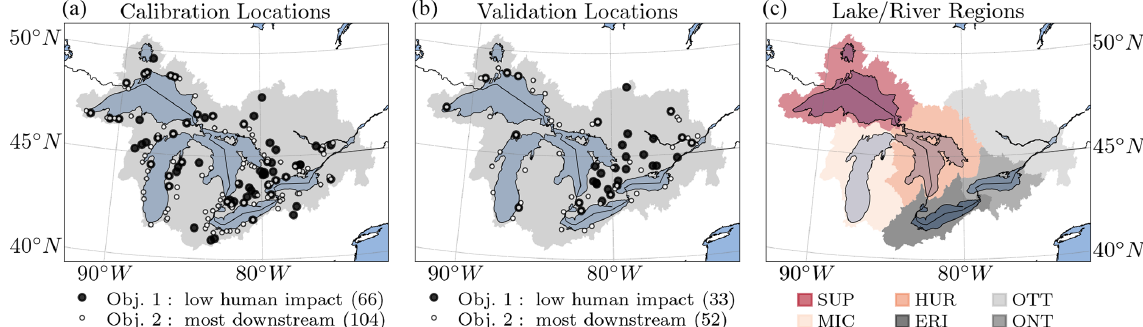
Figure 1. Study domain and streamflow gauging locations. In total, 212 streamflow gauging stations (dots) located in the Great Lakes watershed, including the Ottawa River watershed ( gray area in panels a and b) , have been used in this study. Note that all selected gauging stations eventually drain to one of the Great Lakes or the Ottawa River, and none are downstream of any of the Great Lakes. Hence, most models do not simulate the areas of the Great Lakes themselves. Panel (a) shows the location of stations used for calibration regarding streamflow, where 66 of them are downstream of a low human impact watershed (objective 1; large black dots), and 104 stations are most downstream, draining into one of the five lakes or the Ottawa River (objective 2; smaller dots with a white center). In total, there are 141 stations used for calibration, as 29 stations are both low human impact and most downstream (large black dots with white center; 141 = 66 + 104 − 29). Panel (b) shows the 71 validation stations, of which 33 are low human impact, 52 are most downstream, and 14 are both low human impact and most downstream (71 = 33 + 52 − 14). The number of stations is added in parenthesis to the labels in the legend. Panel (c) shows the six main regions of the study domain, i.e., the Lake Superior region (SUP), the Lake Michigan region (MIC), the Lake Huron region (HUR), the Lake Erie region (ERI), the Ottawa River region (OTT), and the Lake Ontario watershed